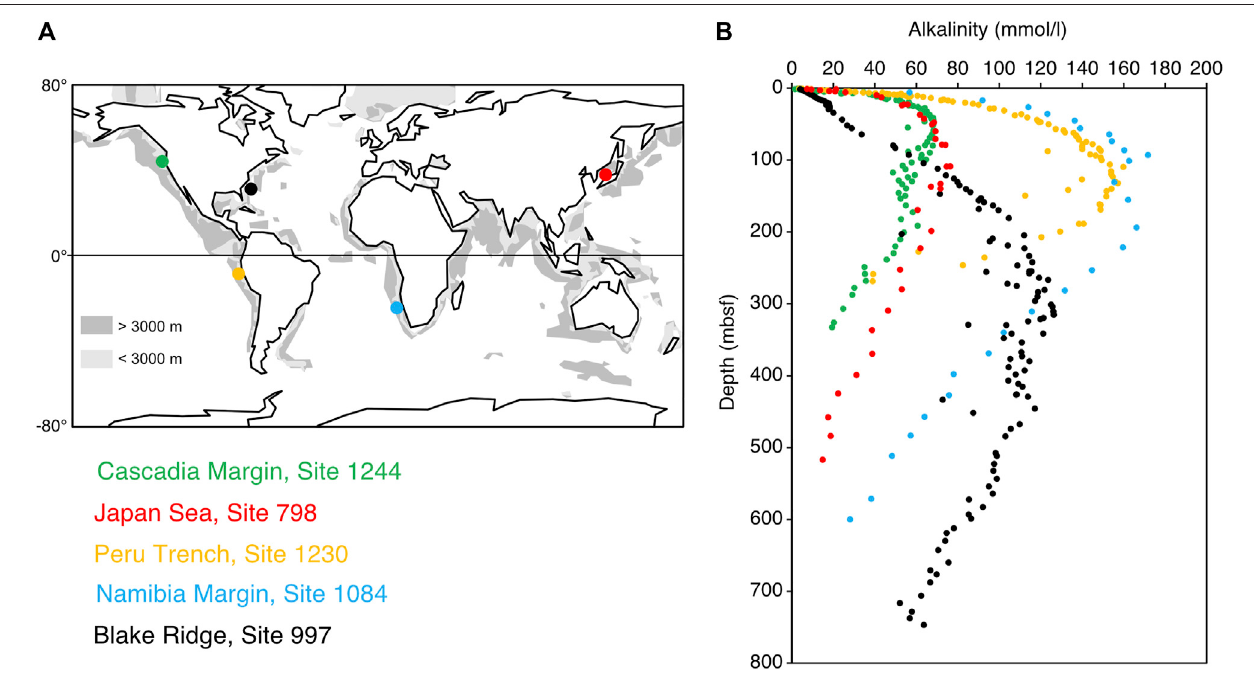
FIGURE 1 | Global map showing representative ODP sites along continental margins with thick methanogenic zones (A) and compilation of their porewater alkalinity pro fi les with respect to metres below sea fl oor (mbsf), highlighting greatly elevated alkalinity in the upper few hundreds of metres of sediment (B) . Data are from Ingle et al. (1990; Japan Sea, Site 798), Paull et al. (1996; Blake Ridge, Site 997), Wefer et al. (1998; Namibia Margin, Site 1084), D ’ Hondt et al. (2003; Peru Margin, Site 1230), and Tréhu et al. (2003; Hydrate Ridge, Site 1244).